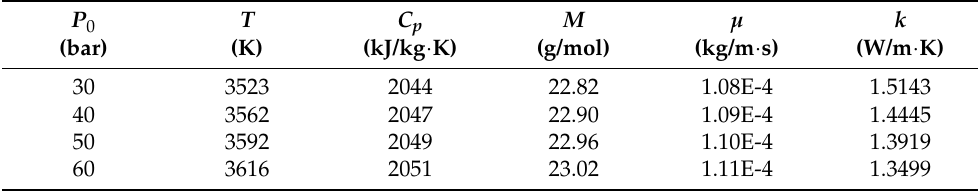
Table 2. Properties of the burnt gas used in the